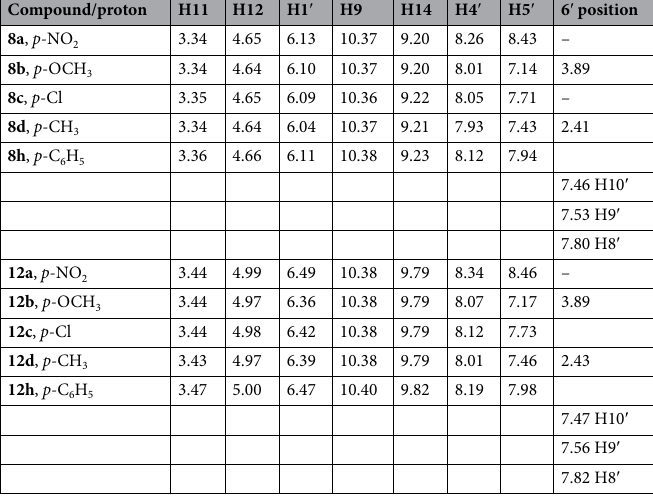
Table 1. The main 1 H-NMR spectral data for the most biologically active hybrids quinoline–imidazole/ benzimidazole compounds 8 and 12 .